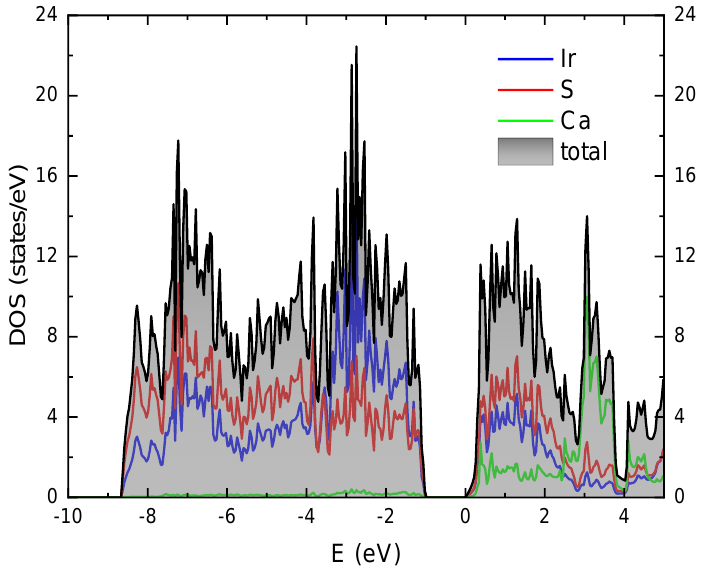
Electron. Mater. 2022 , 3 , FOR PEER REVIEW Figure 7. Total and partial density of states for each atomic species for the stoichiometric CaIr 4 S 8 .